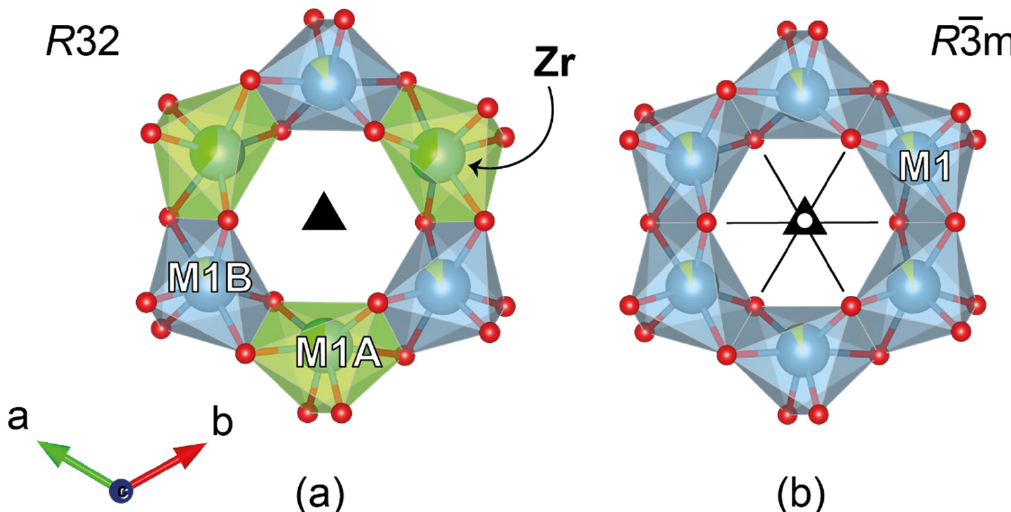
Figure 8. The splitting of the M1 site into the M1A and M1B sites in the crystal structure of LV-117/226 ( a ) and absence of splitting for 153/178 ( b ) eudialyte samples from Mt. Kedykvyrpakhk, Lovozero massif. Light-green octahedra represent mixed Ca/REE M1B sites, light blue—mixed Ca/Zr M1A (M1) sites. The local symmetry elements are indicated without a two-fold axis to sim- plify.